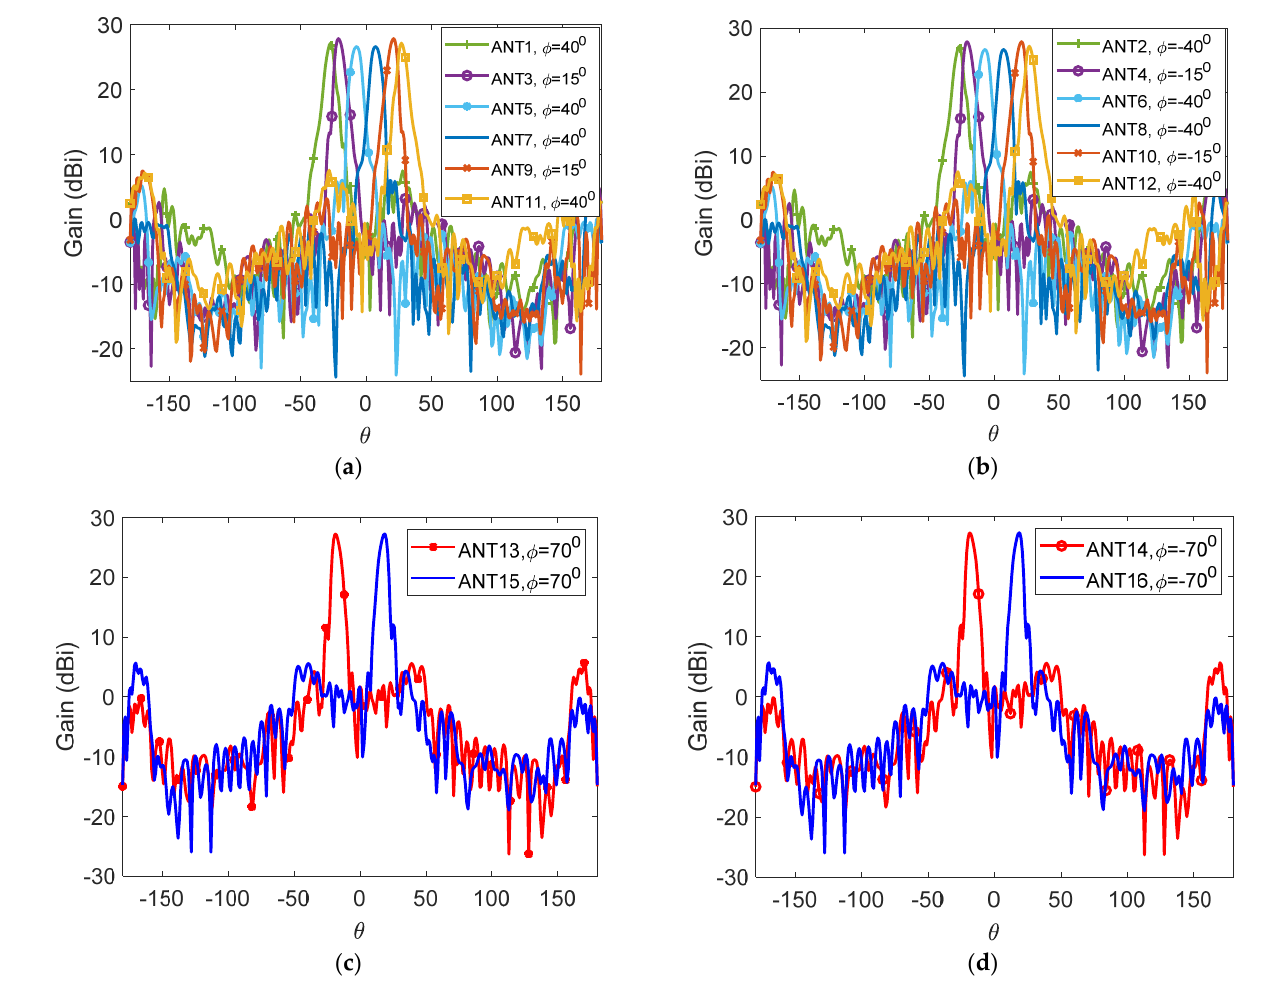
Figure 8. Co ‐ polarized radiation patterns of sixteen switchable horn antennas with the proposed reconfigurable dielectric lens. ( a ) Antennas 1, 3, 5, 7, 9 and 11. ( b ) Antennas 2, 4, 6, 8, 10 and 12. ( c ) Antennas 13 and 15. ( d ) Antennas 14 and 16.